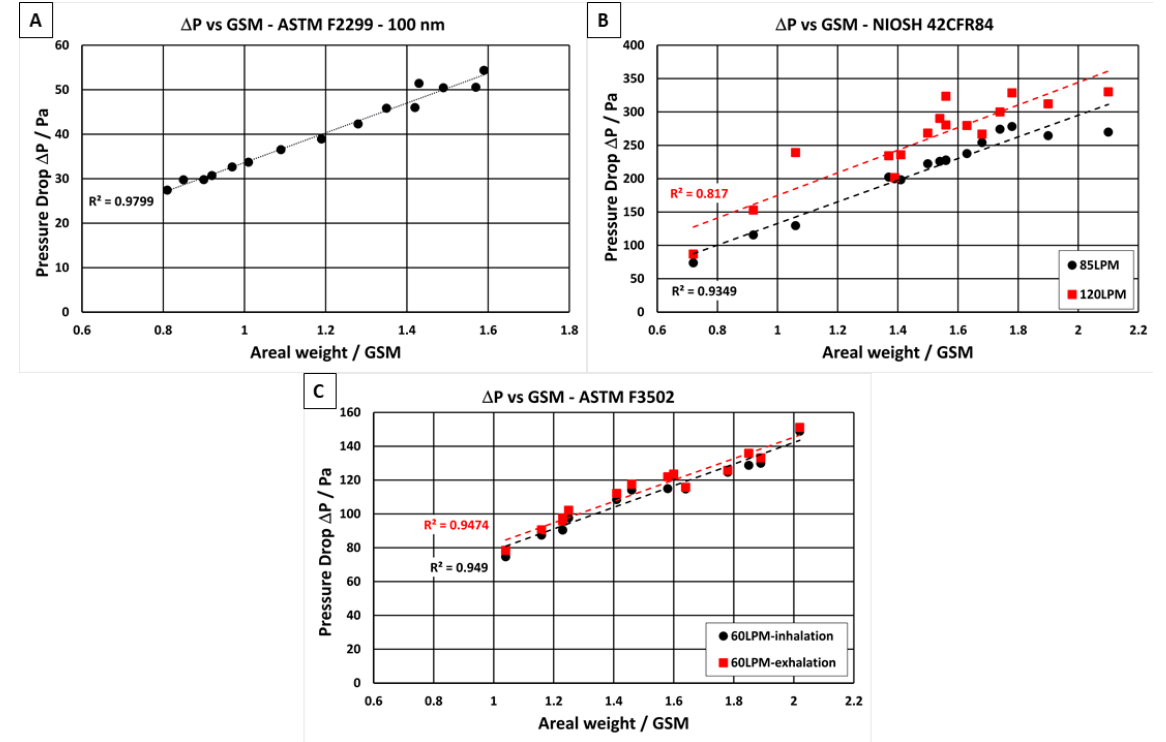
Figure 4. Relationships between pressure drop ( Δ P) and nanofibre areal weight (in gsm) when tested in accordance with different international standards: ( A ) ASTM F2299, ( B ) NIOSH 42CFR84, and ( C ) ASTM F3502.